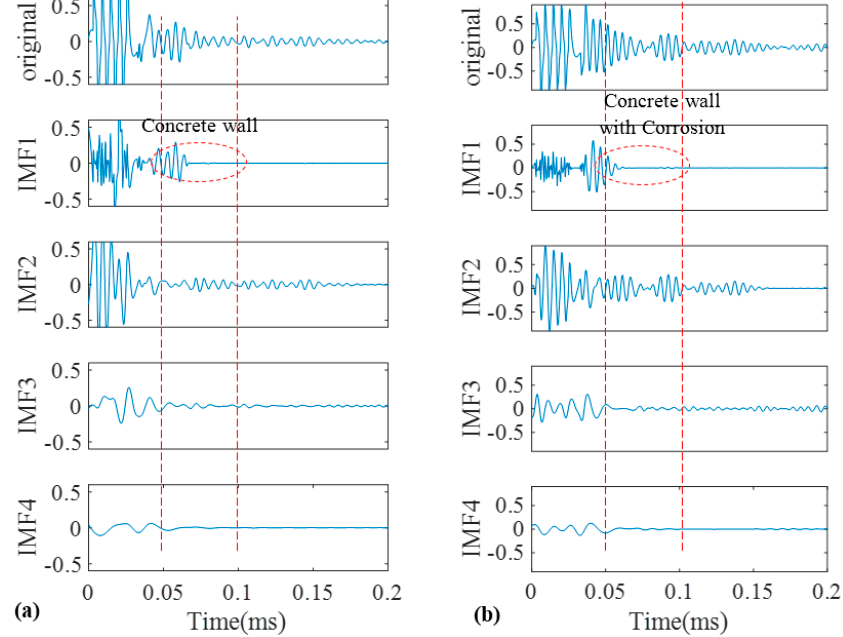
Figure 19. Decomposition of field test signals into their IMFs by EEMD for the pristine pipe ( a ); and the pipe with a natural corrosion ( b ).